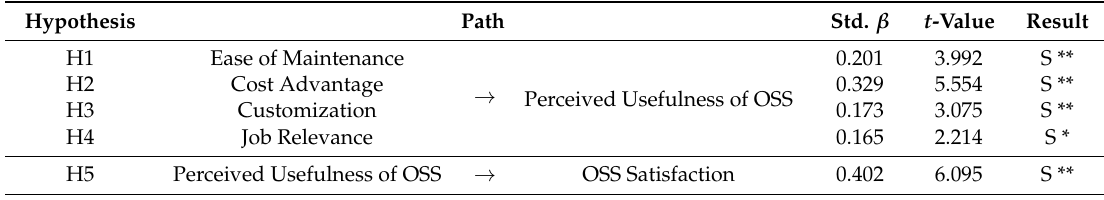
Table 8. Summary of hypothesis tests (Female group, n =